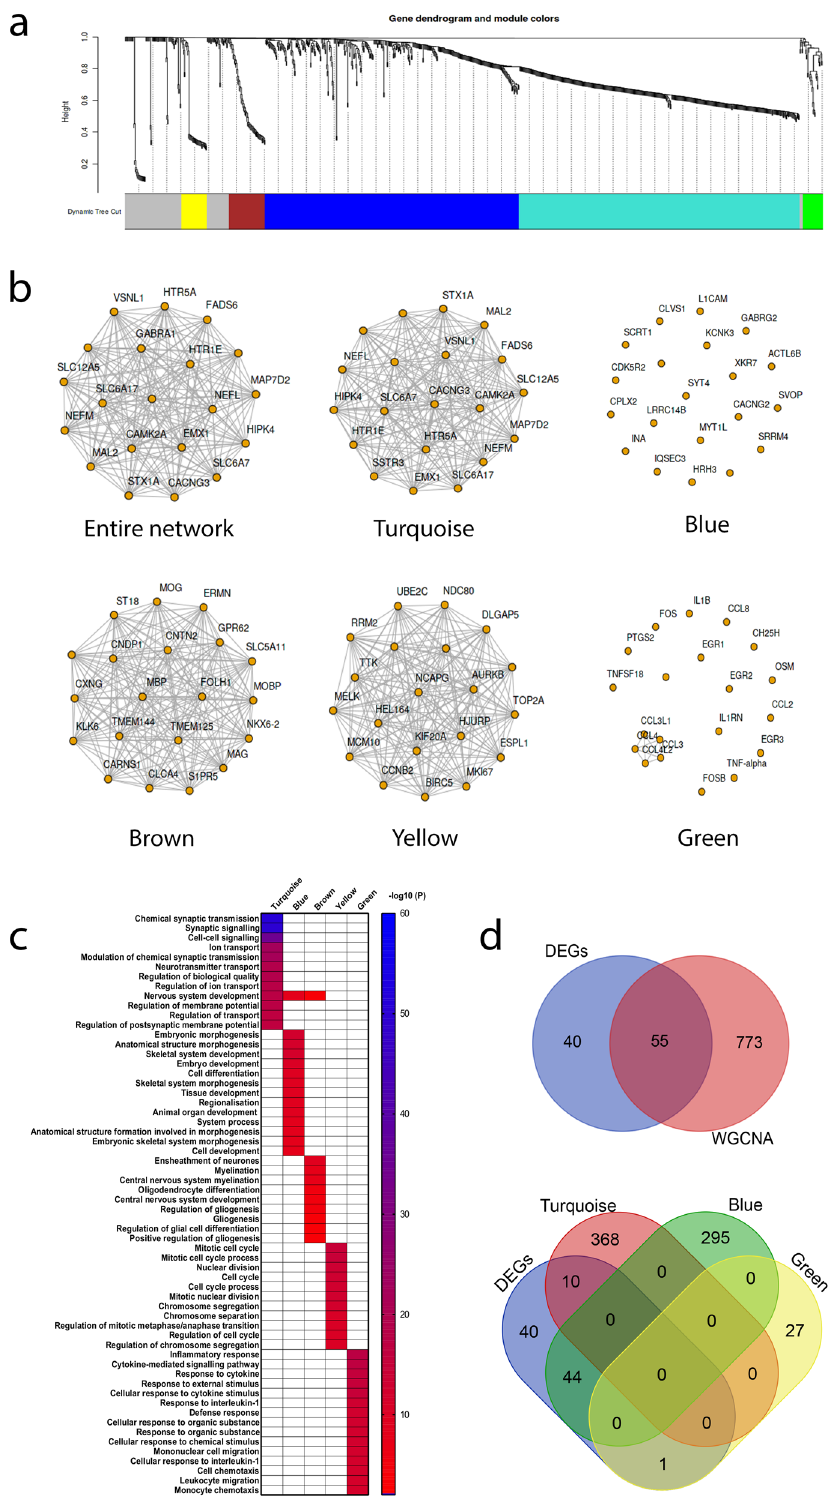
Figure 6. WGCNA of the TCGA WHO grade II LGG dataset identified a network of 882 genes divided into five co-expression modules. ( a ) Gene dendrogram. Colours are randomly assigned except grey which represents areas unassigned to a module. ( b ) Networks of the top 20 genes for the entire network and each module individually. ( c ) Visualisation of the GO enrichment analysis for each module; heatmap was produced in GraphPad. ( d ) Venn analysis to identify common genes returned by both WGCNA and DEG